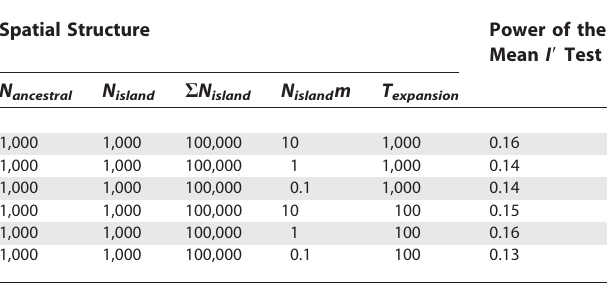
Table 5. The Power of the Mean I 9 Test to Detect Tree Imbalance under a Model of Range